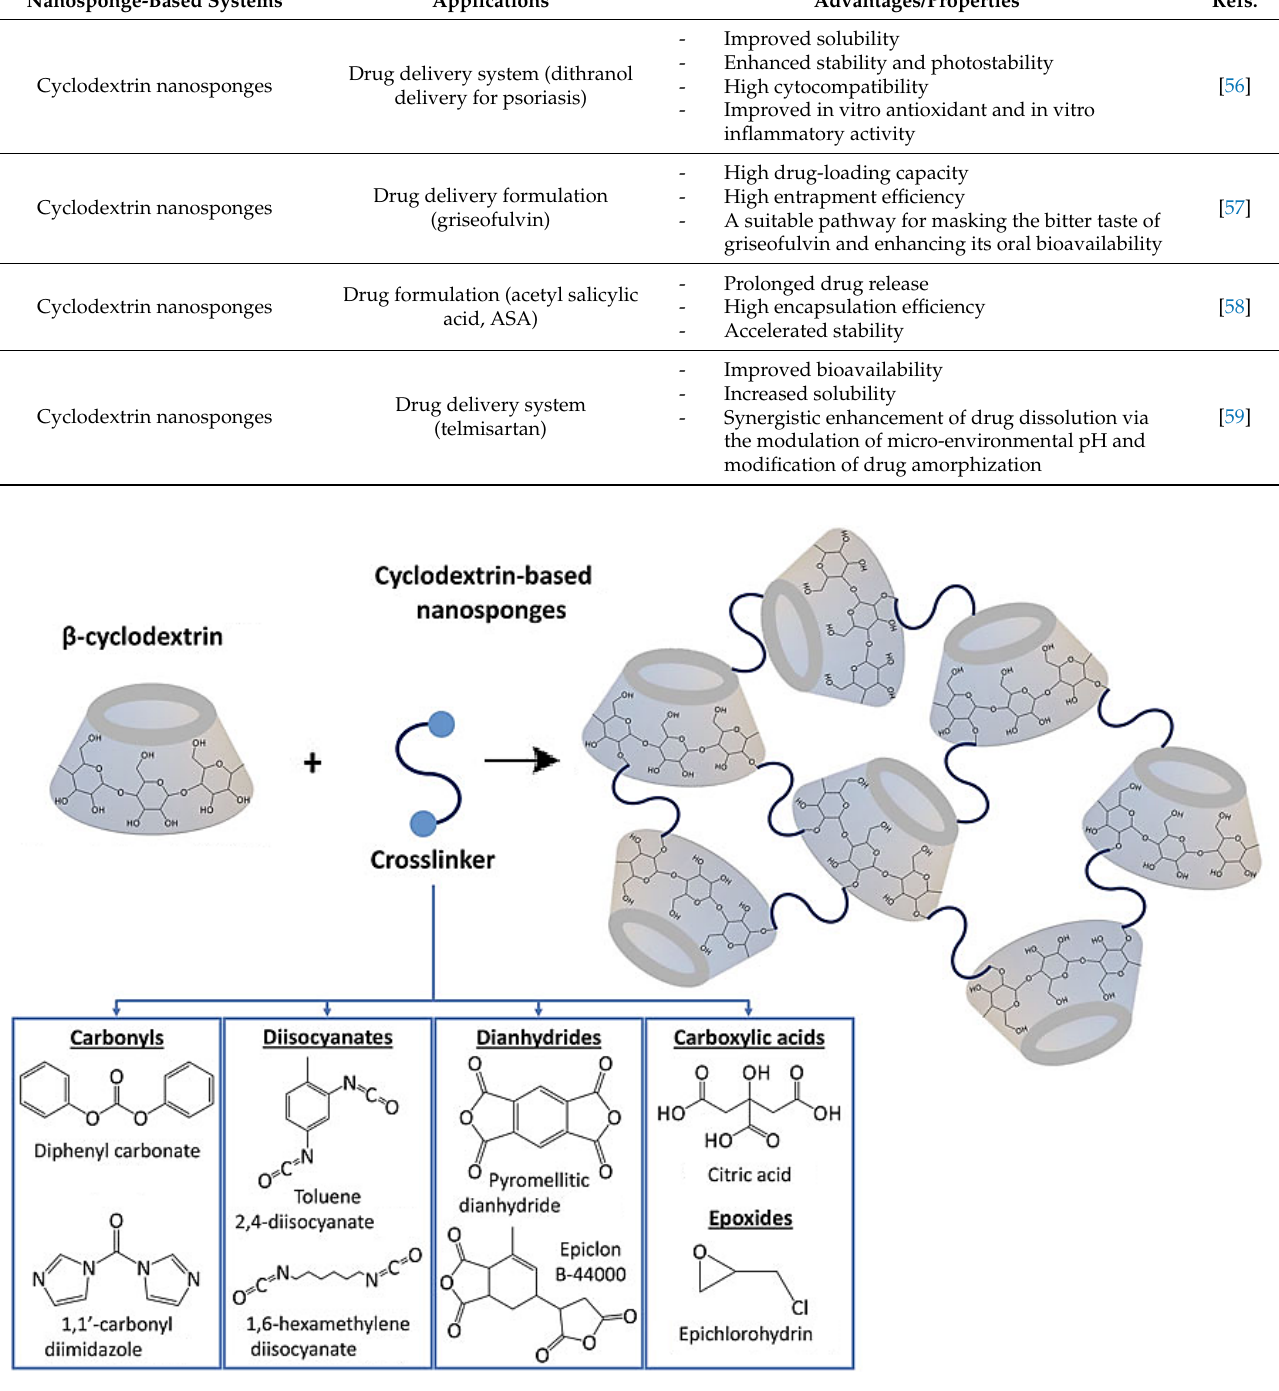
Figure 2. Assorted cross-linkers applied for manufacturing cyclodextrin nanosponge-based systems. Adapted from [12] with permission. Copyright 2022 Frontiers (CC BY 4.0).